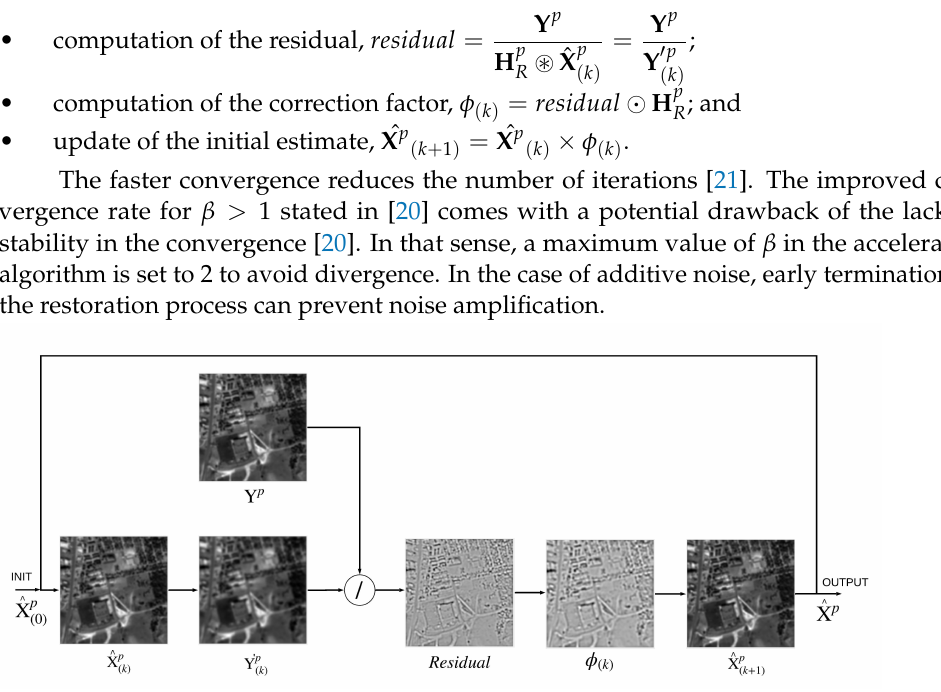
Figure 3. An illustration of one iteration of a Richardson-Lucy (RL) deconvolution algorithm.